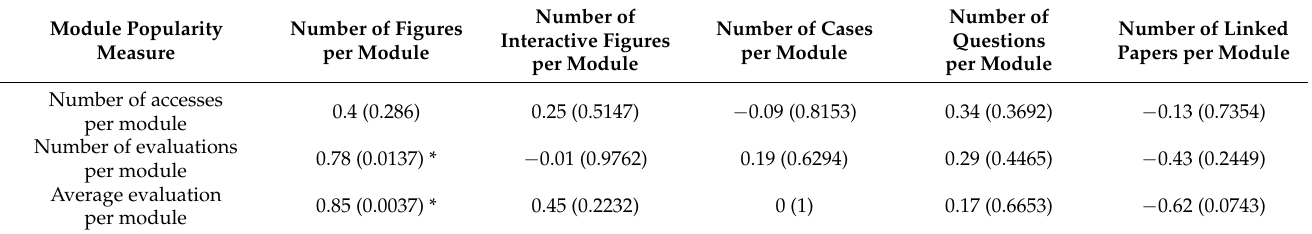
Table 2. Correlation between design and popularity of 9 digital teaching